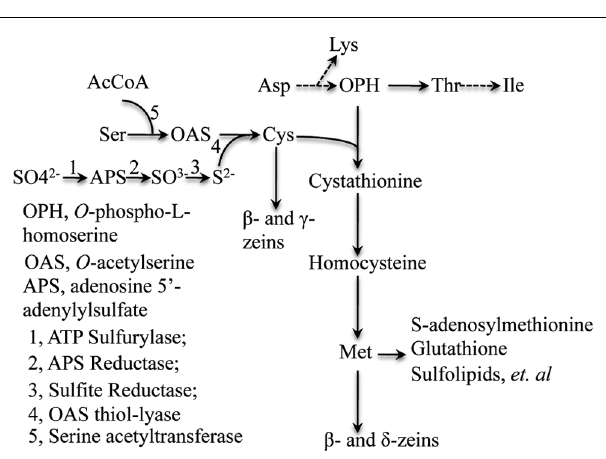
FIGURE 3 |Accumulation patterns of zeins in high-methionine transgenic andWT seeds. Hi-Met transgenic seeds in lane 2 and 4 express much higher levels of the 10-kDa δ -zein, but lower levels of β - and γ -zeins thanWT in lane 1 and 4. Adapted fromWu etal. (2012).